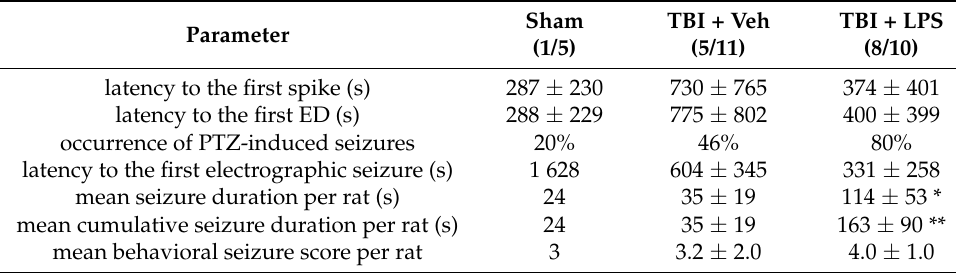
Table 1. Electroencephalograhic (EEG) events in the pentylenetetrazol (PTZ) seizure susceptibility test at 23 weeks after traumatic brain injury (TBI) and 15 weeks after lipopolysaccharide (LPS) administration in the whole animal